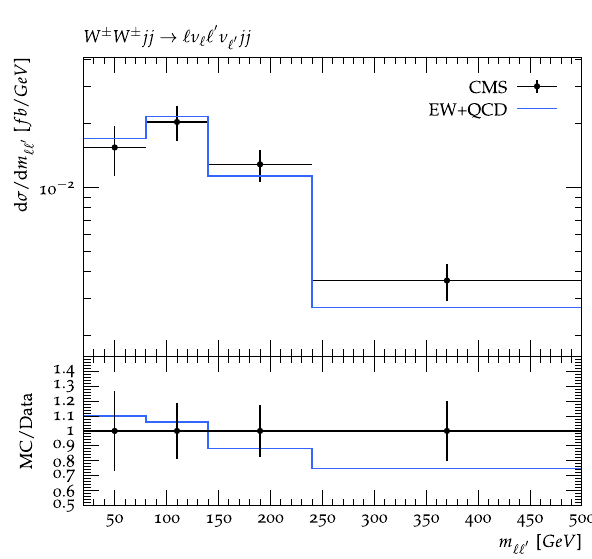
Fig. 4 The dilepton invariant mass distribution m ll (cid:3) from the CMS measurements of same-sign W ± W ± jj production [15], compared with the corresponding diboson (QCD-induced) plus theVBS (EW-induced) theoretical predictions. The error bar on the CMS data points indicates the total experimental uncertainty. In the lower panel, we display the ratio of theory over